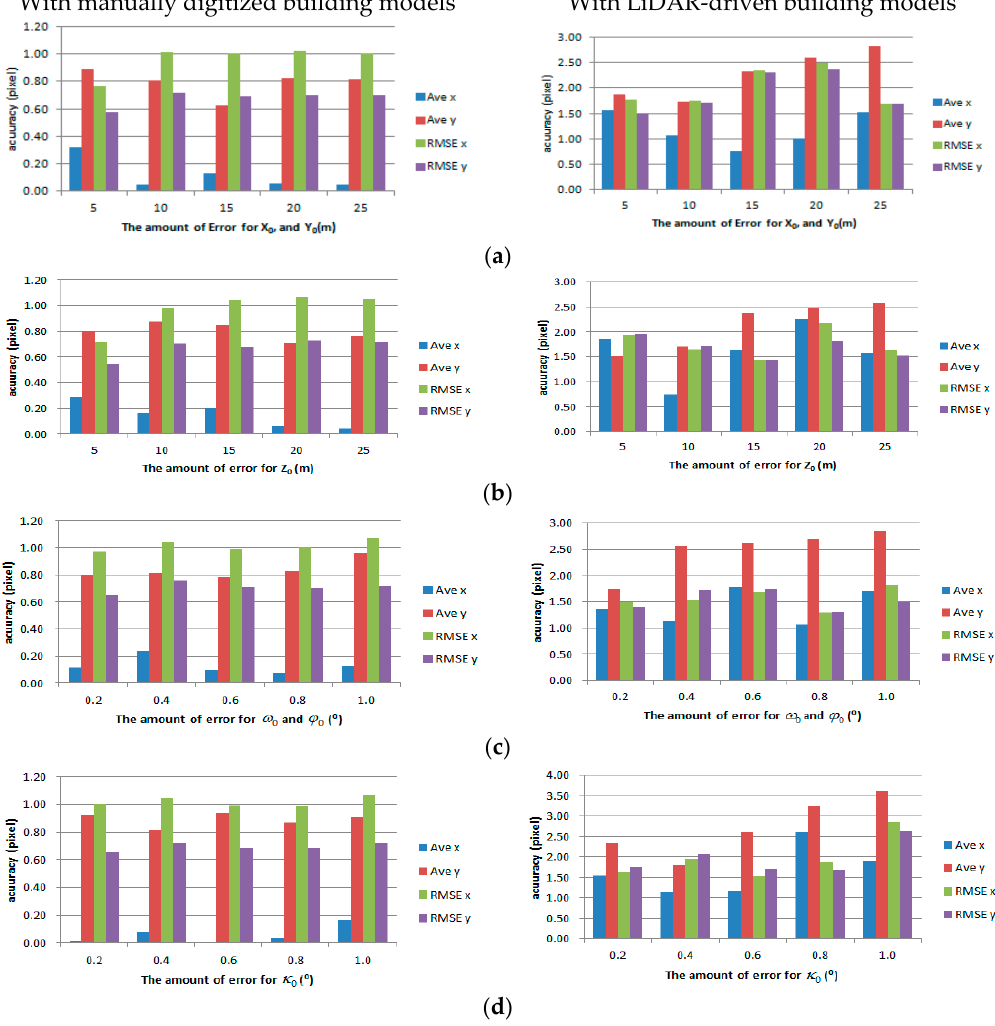
; and ( d ) (cid:2018) 0 . Figure 15. The impacts of errors in initial EOPs: ( a ) (cid:1850) 0 and (cid:1851) 0 ; ( b ) (cid:1852) 0 ; ( c ) (cid:2033) 0 and (cid:2030) 0 Figure 15. The impacts of errors in initial EOPs: ( a ) X 0 and Y 0 ; ( b ) Z 0 ; ( c ) ω 0 and ϕ 0 ; and ( d ) κ 0 . Table 7. Extracted features and matched features (the Vaihingen dataset). Table 7. Extracted features and matched features (the Vaihingen dataset). Image Model Image